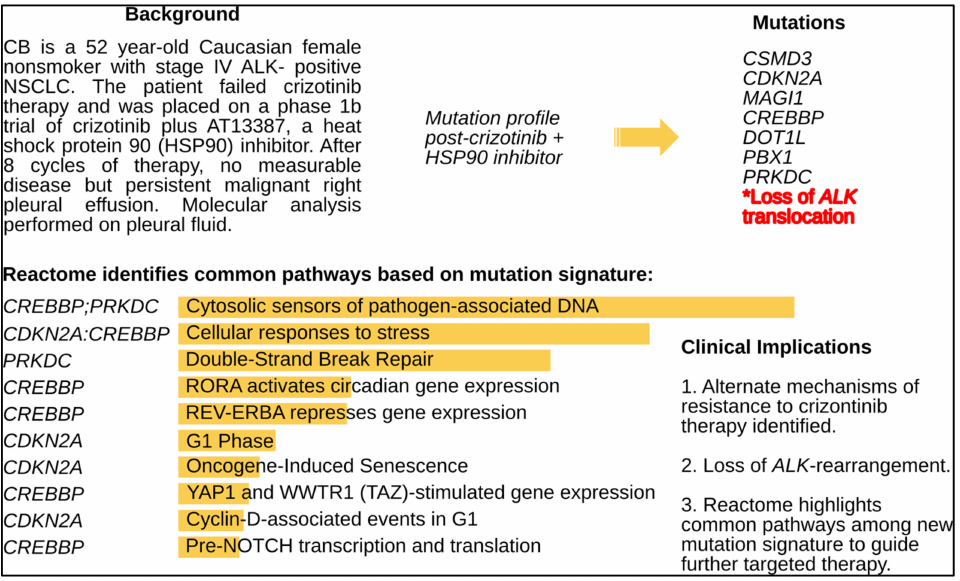
Figure 6. Targetable signaling pathways with of loss EML4-ALK in a patient (Case #9) with non-small cell adenocarcinoma of the lung cancer (Case #9) progressing on crizotinib plus an HSP90 inhibitor.